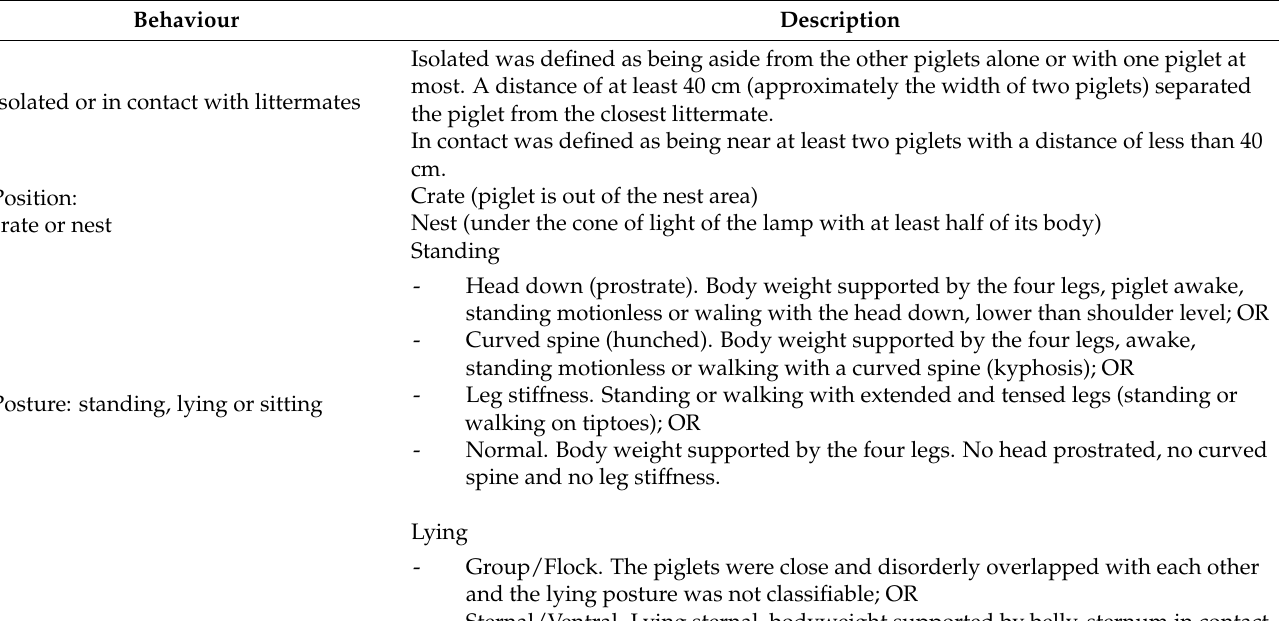
Table 2. Ethogram including description of variables included in scan sampling of general and pain-related behaviours in piglets post-castration in this